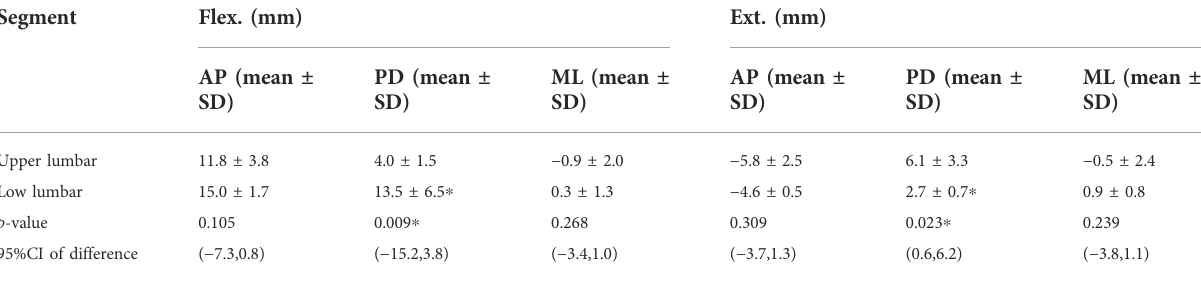
TABLE3Segment-related(upperlumbar,lowerlumbar)meanmarkerartifact(mean)withtheirstandarddeviations(SD)ofthelumbarskinmarkersin the fl exed and extended positions and the 95% con fi dence interval (95% CI) of difference. Segment